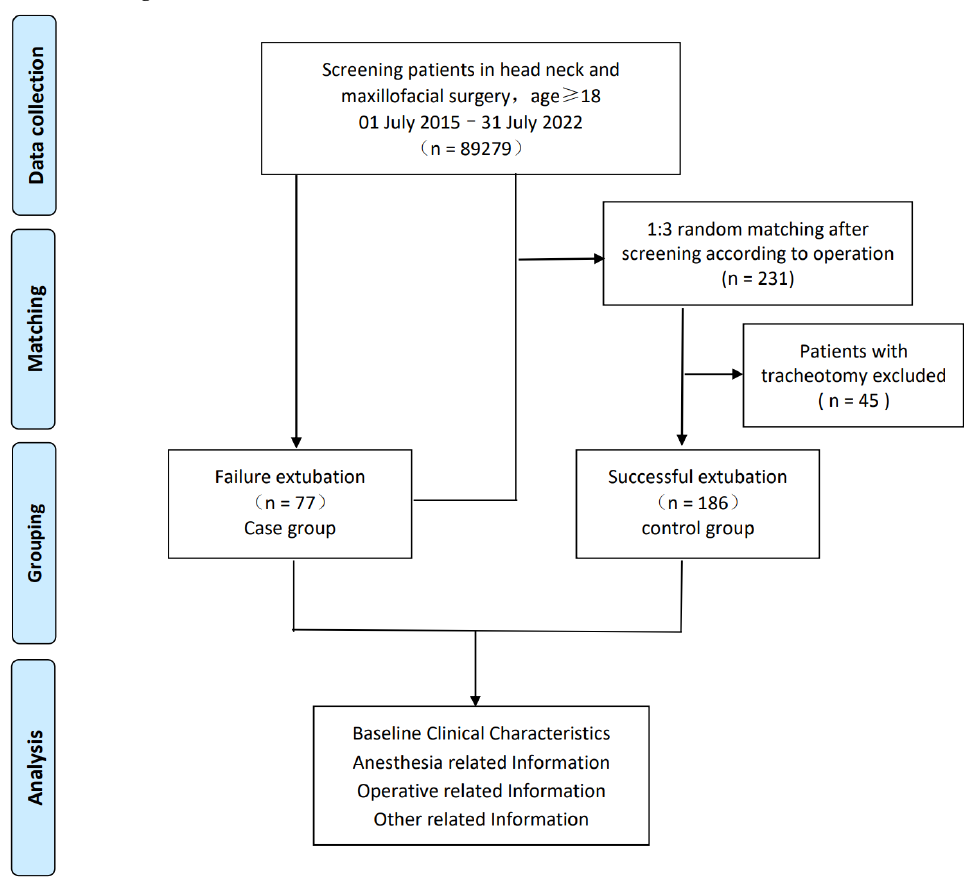
Figure 1. Flow chart of the case – control study.